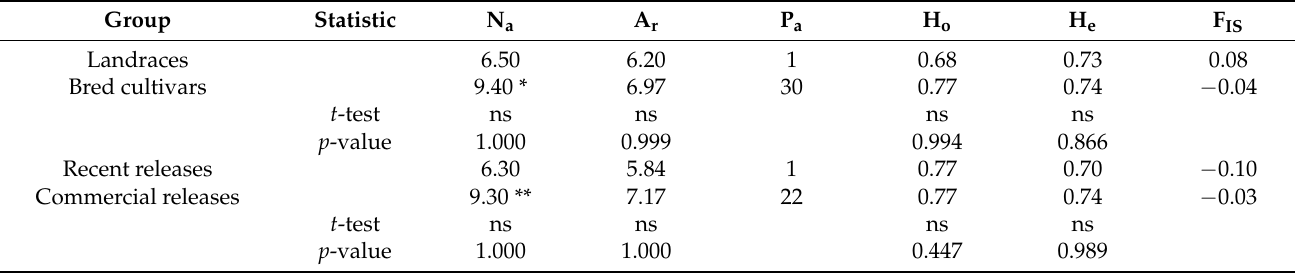
Table 3. Genetic parameters of apricot landraces and cultivars released from breeding programs (commercial and recent). Mean number of alleles (N a ), mean allelic richness (A r ), number of private alleles (P a ), mean observed heterozygosity (H o ), mean expected heterozygosity (H e ), and mean inbreeding coefficient (F IS ). Group Statistic N a A r P a H o H e F IS